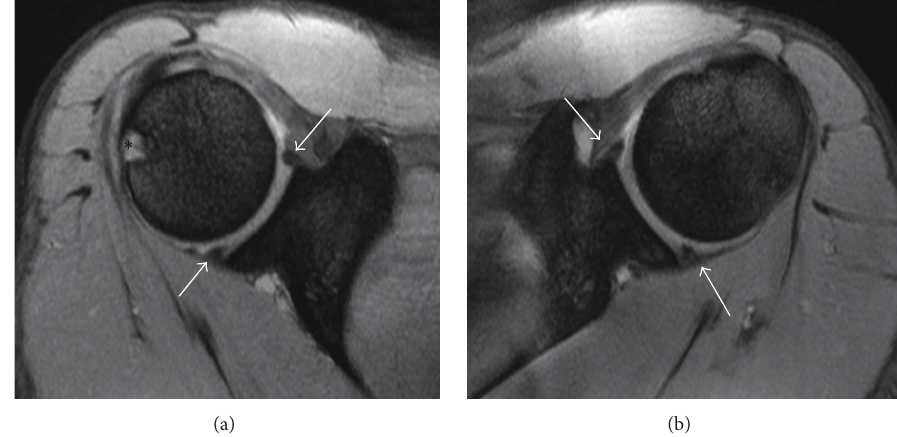
Figure 4: Axial DP FS SE MR images of the right (a) and left (b) shoulder (TR = 475; TE = 13.43; NEX = 1; EC = 1) showing normal labrum morphology bilaterally, without evidence of tears (white arrows). In (a) there is a cyst beneath the lateral humeral head margin, without pathologic significance